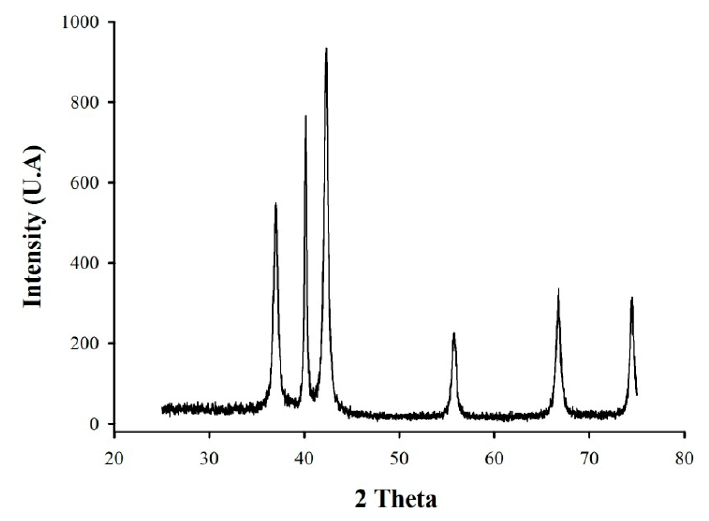
Figure 1. X-ray di ff raction of the synthetic zinc oxide nanoparticle (Zincite-ZnO NP). Figure 1. X-ray diffraction of the synthetic zinc oxide nanoparticle (Zincite-ZnO NP).